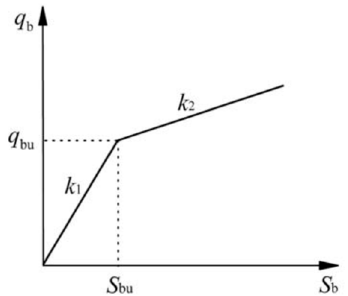
Figure 4. Load transfer model for pile tip.